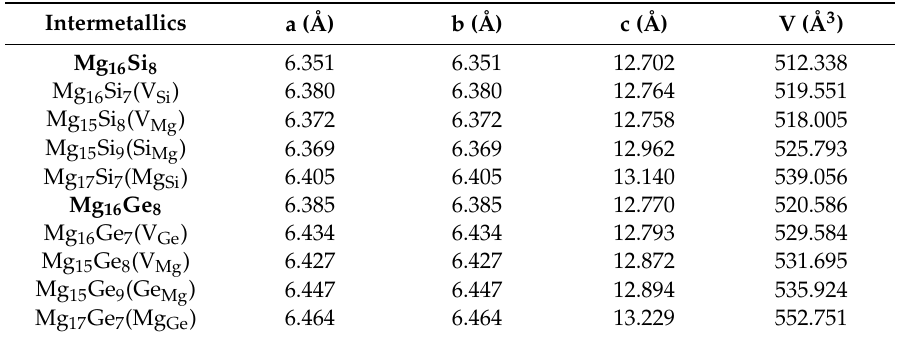
Table 1. Calculated equilibrium lattice constants of 1 × 1 × 2 Mg 2 X (X = Si, Ge) cells with or without two types of point